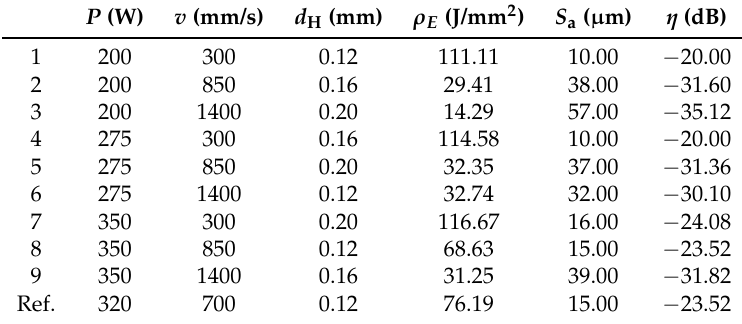
Table 7. Factors and their respective levels for the experiments regarding upskin and reference with manufacturers’ settings.